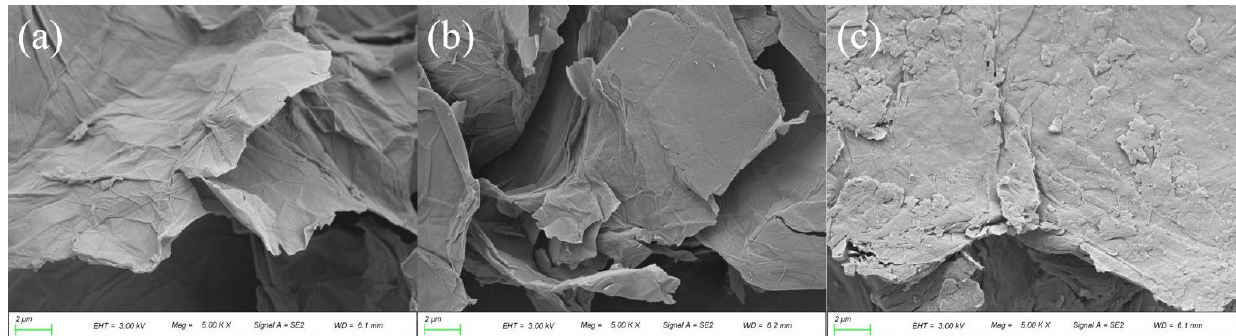
Figure 2. SEM images of the prepared GO sheets ( a ), GO-RAFT ( b ), and GO-MIPs ( c ).